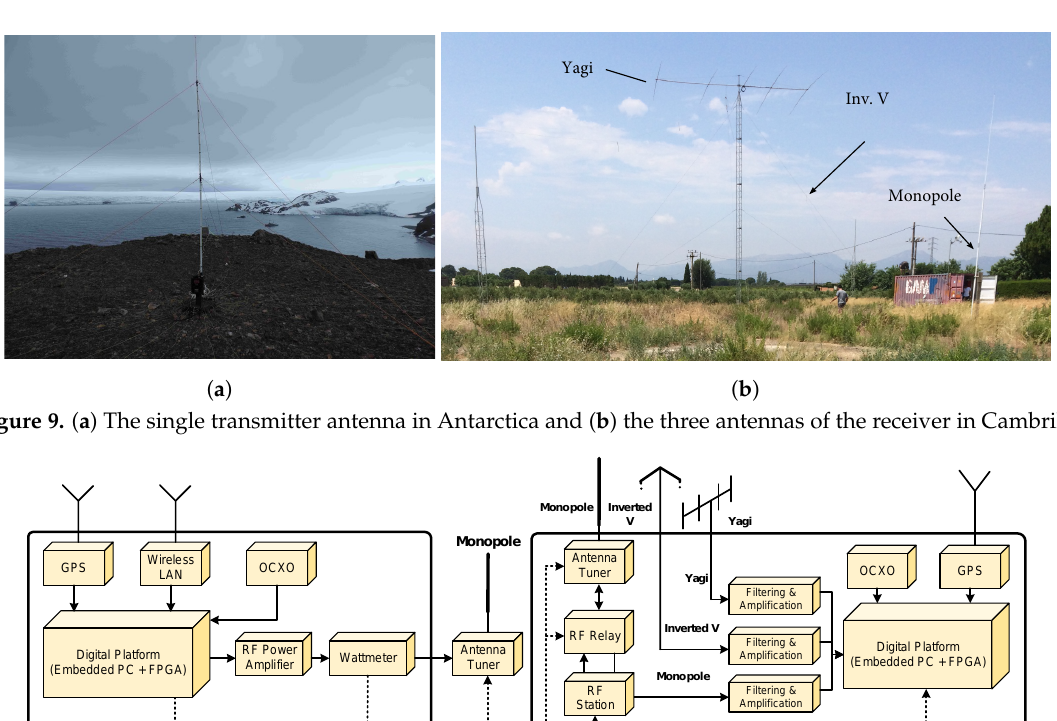
Figure 8. Geographical link characteristics. The transmitter is located in the Spanish Antarctic Station on Livingston Island, and the receiver is placed in Cambrils, Spain. The transmitter was placed at the top of a hill close to the Station (see Figure 10a for a block diagram and Figure 9a for a picture of the location). The receiver was placed in Cambrils, a village located 100 km south of Barcelona, in a quiet electromagnetic environment. A block diagram of the receiver is shown in Figure 10b and a photograph is shown in Figure 9b.